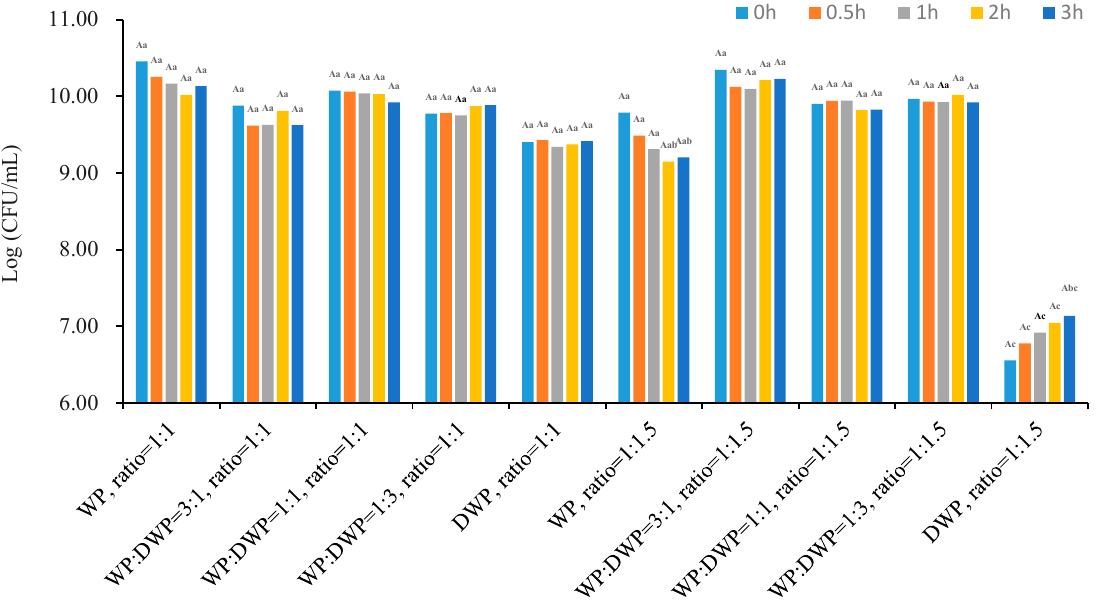
Figure 6. Viability of lyophilized L. plantarum 299v with different core-to-wall ratios and formulations after exposed to SGJ at 37 ◦ C for 3 h. WP: whey protein, DWP: denatured whey protein. Superscript letters indicate significant differences ( p < 0.05) among incubation time for a given micro ‐ capsule.